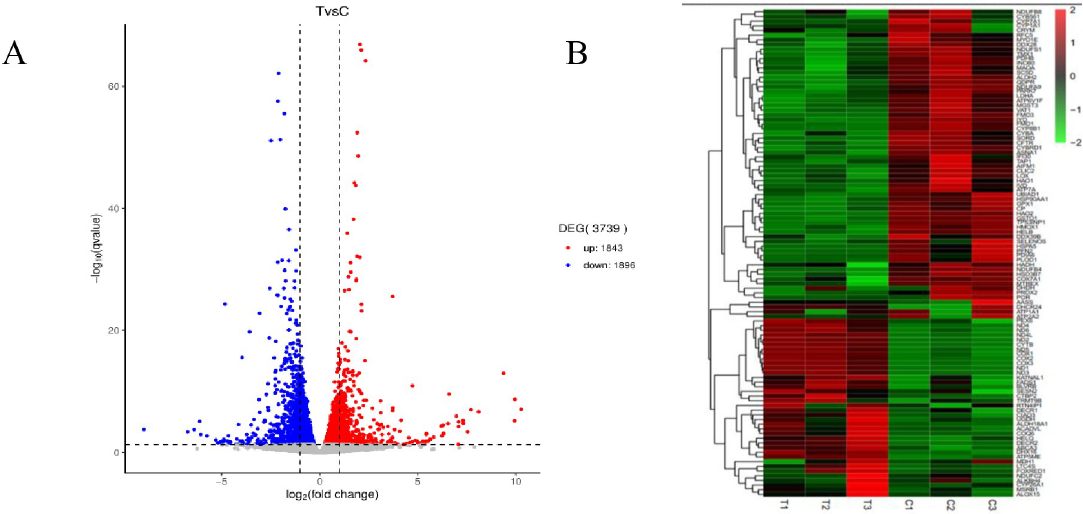
Fig 2. Analysis of differential genes in liver of WAE group and CON group. (A) Volcano map: Genes with significant differential expression were represented by red dots (up-regulated) and blue dots (down-regulated), and genes with no significant differentially expression were represented by gray dots; The abscissa represented the fold change of gene expression in different samples; the ordinate represented the statistical significance of the difference in gene expression. (B) The DEGs cluster map: red is significantly up-regulated gene, green was a significantly down-regulated gene, and regions with different colors represent different clustering grouping information.